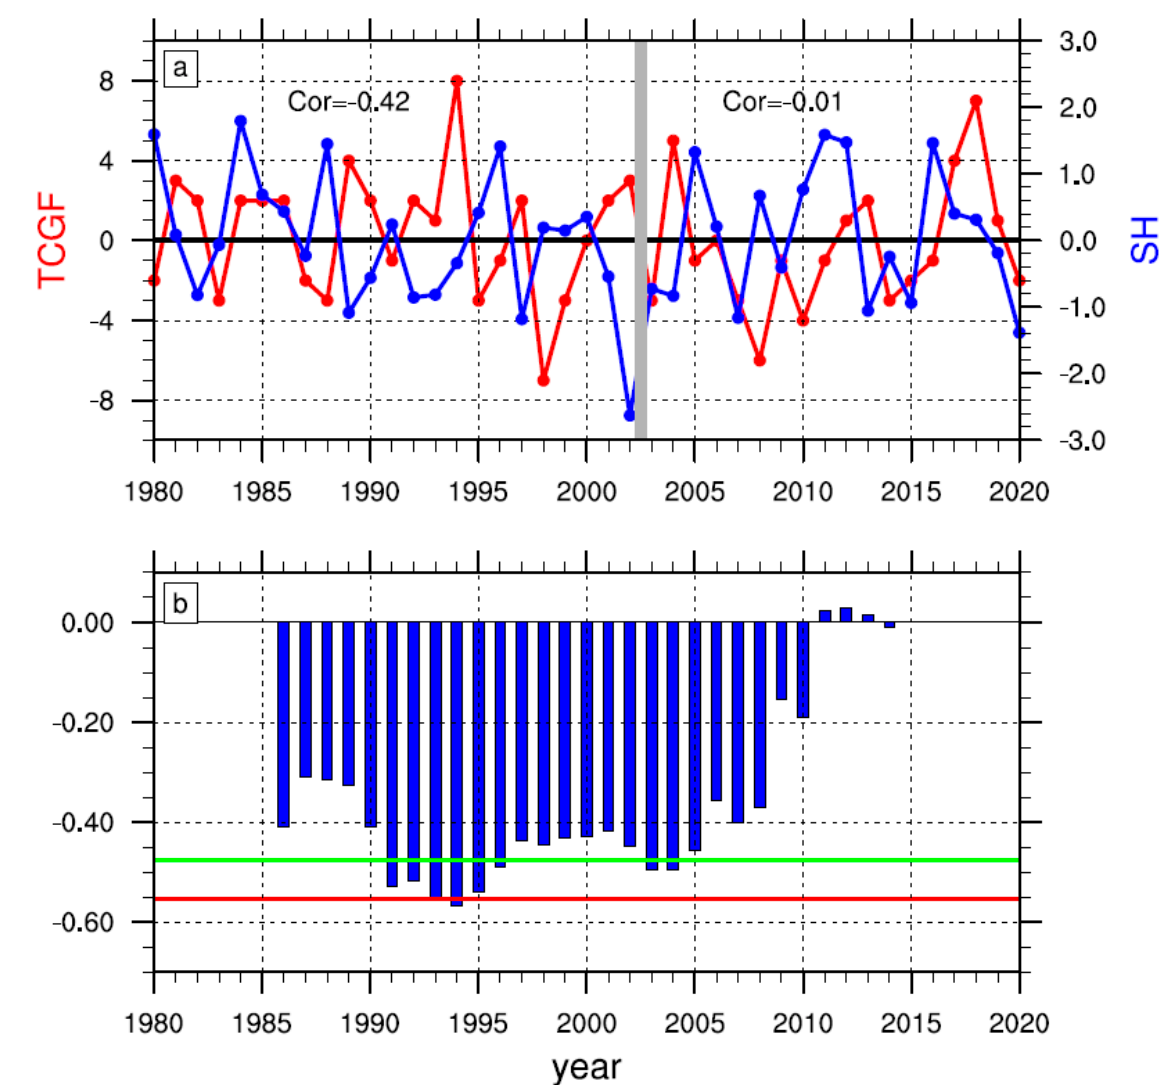
Figure 1. ( a ) Time series of the (blue) JFM SH index and (red) JJA TCGF index during 1980–2020. The correlation coefficients shown in the upper left and right are correlations during 1980–2002 and 2003–2020, respectively. ( b ) The 13-year sliding correlation coefficients between JFM SH index and JJA TCGF index during 1980–2020. The solid green (red) line indicates statistical significance at 90% (95%) confidence level based on the two-sided Student’s t -test.